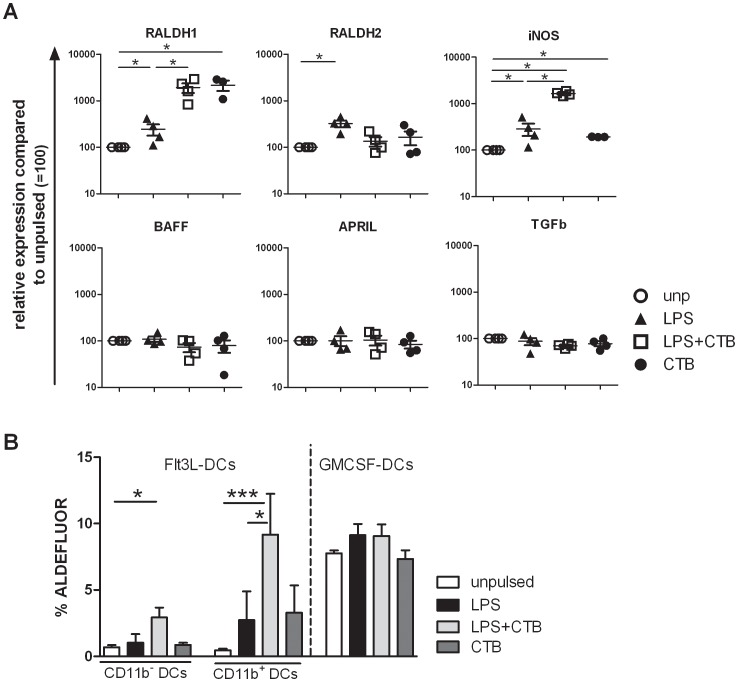
Expression of candidate IgA inducing molecules of BM-DCs.(A) BM-DCs were cultured as described previously and pulsed with PBS, LPS (1 ng/ml) +/− CTB (10 µg/ml) or CTB alone. After 24 hrs the following gene expression was analyzed (A) RALDH1, RALDH2, iNOS, BAFF, APRIL and TGF-β. Expression is normalized against the house keeping gene GAPDH and displayed as relative to conventional unpulsed BM-DCs. Mean+sem of 4 indvidual BM-DC cultures are shown. (B) BM-DCs were generated by culture in GM-CSF or Flt3-L, and pulsed as described. After 24 hours, cells were washed and stained for ALDEFLUOR activity (according to the instructions of the manufacturer), CD11c, CD11b and MHCII expression and analyzed by flowcytometry. The results are a mean+sem from 4 independent experiments. * P<0.05, ** P<0.01, *** P<0.001.